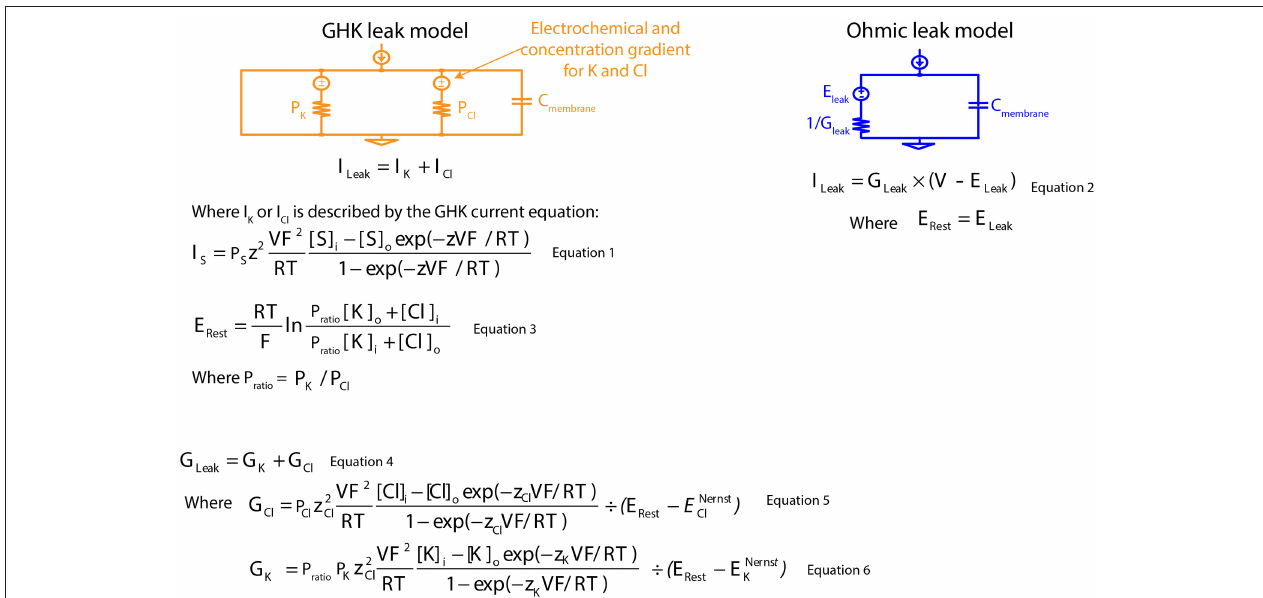
FIGURE 1 | Mathematical descriptions of the Ohmic and Goldman-Hodgkin-Katz leak-current models. GHK, Goldman-Hodgkin-Katz; P K , absolute permeability value of K + ; P Cl , absolute permeability value of Cl − ; C membrane , specific membrane capacitance; I Leak , leak current; I K , K + component of GHK leak current; I Cl , Cl − component of GHK leak current; S, permeating ion; I S , GHK-type S leak current; P S , absolute permeability value of S; z, ionic charge of S; V, membrane potential; F, Faraday’s constant; R, gas constant; T, absolute temperature; S i and S o , intra- and extracellular concentration of S; E Rest , resting membrane potential; P ratio , permeability ratio; [K] i and [K] o , intra- and extracellular concentration of K + ; [Cl] i and [Cl] o , intra- and extracellular concentration of Cl − ; G Leak , membrane leak conductance; G K , K + component of membrane leak conductance; G Cl , Cl − component of membrane leak conductance; z Cl , ionic charge of Cl − ; E Nernst Cl ,